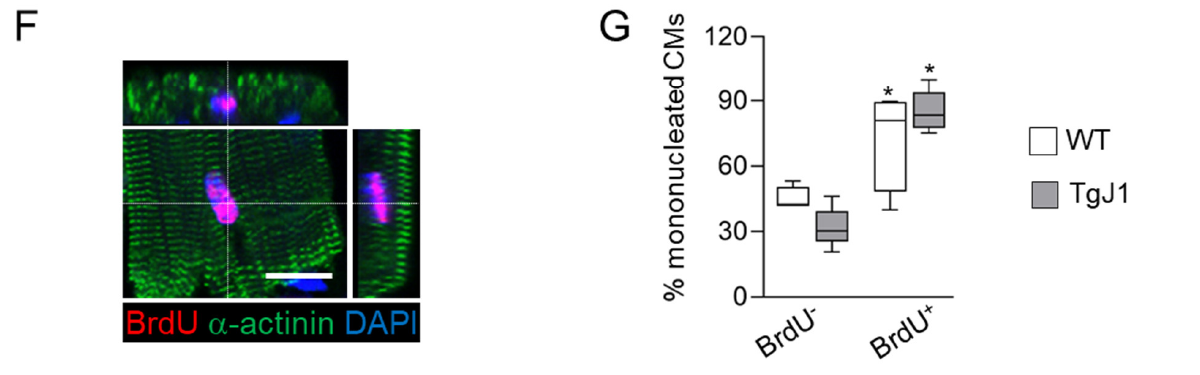
Figure 3. Aortic constriction increased BrdU incorporation in the myocardium. Mice were subjected to Sham or TAC operation as in Figure 1A and heart tissue sections were subjected to immunostaining to reveal BrdU incorporation. ( A ) Micrographs showing tissue sections stained with antibodies against BrdU (Gray), α -actinin (red), Laminin (green) and DAPI (blue). ( B ) Quantitative analysis of total BrdU incorporation expressed as percentage of BrdU+ nuclei. ( C ) Examples of BrdU+ CMs in the myocardium, identified by virtue of BrdU+ nuclei within sarcomeric α -actinin+ cytoplasm delimited by a laminin+ signal to mark CM boundaries. The insets show the BrdU+ CMs at high magnifications. ( D ) Quantification of BrdU+ CMs. The results are expressed as percent BrdU+ CMs relative to total CMs with visible nuclei. ( E ) Examples of small BrdU+ CMs. The micrographs show small α -actinin+ and BrdU+ CMs (arrows) with faint laminin extracellular matrix organization in sub-endocardial regions ( a ), in proximity of blood vessels ( b ), and in the myocardium ( c ). ( F , G ) Single CMs isolated from WT and TGJ1 mouse hearts subjected to TAC and α NRR1 treatment were immunostained using antibodies against BrdU (red) and α -actinin (green) and DAPI. ( F ) Confocal image of a BrdU+ CM isolated from adult heart with orthogonal views showing BrdU+ nucleus within α -actinin-stained sarcomeres ( G ) The percentage of mono-nucleated BrdU+ (pos.) and BrdU − (neg.) CMs were determined on CMs stained as in ( E ). ( B , D ) n = 5–10 mice/group (see Supplementary Table S2); for ( F ), WT, n = 4; TGJ1, n = 5. *, p < 0.05 in TAC vs. Sham; †, p < 0.05 in α NRR vs. None; ‡, p < 0.05 in TGJ1 vs. WT. Scale bars = 20 µ